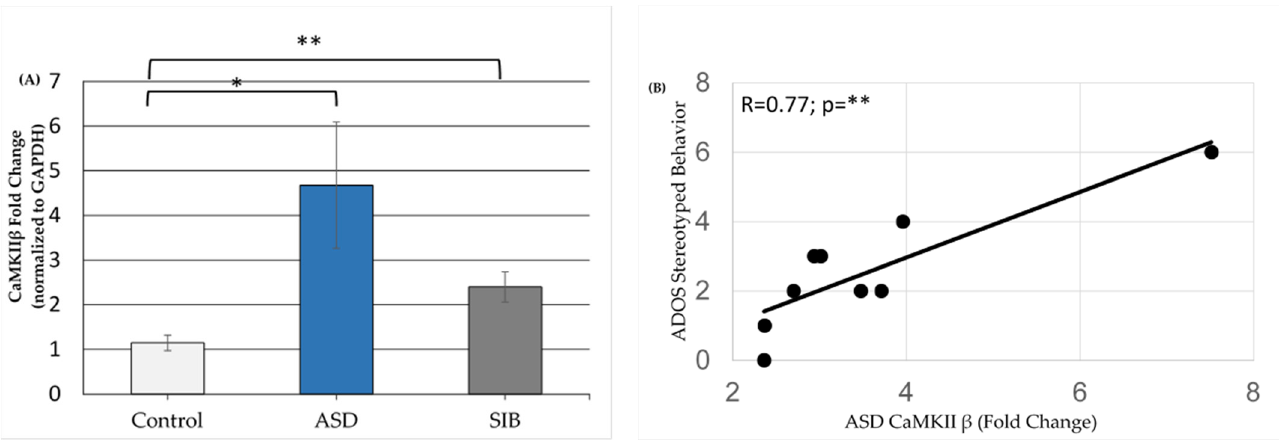
Figure 6. ( A ) CaMKII β expression in LCLs. ( B ) Correlation of CaMKII β expression and stereotyped behavior per ADOS criteria. CNT = control, ASD = autism spectrum disorder, and SIB = Siblings; n = 9–10 in each group; * p ≤ 0.05.; ** p ≤ 0.01.